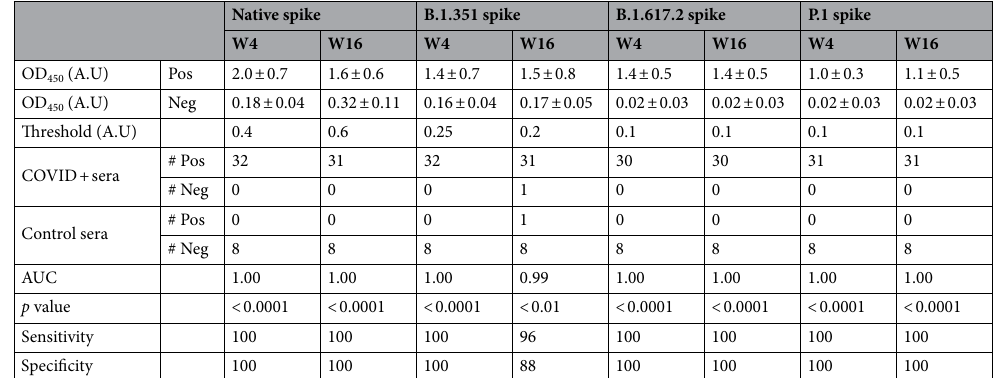
Table 1. ELISA for the detection of IgG targeting the native, B.1.351, B.1.617.2, and P.1 spike proteins using serum from variant-naïve, SARS-CoV-2-positive individuals at weeks 4 and 16 post-diagnosis.